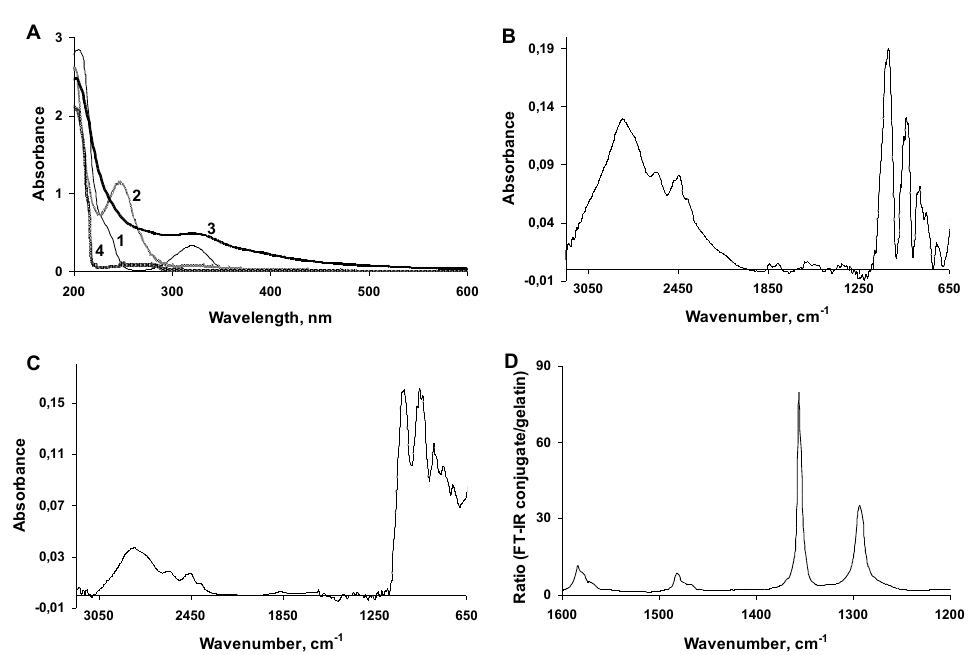
Figure 2. Analysis of the 2,5-DHBA–gelatin conjugate using UV-Vis ( A ) and FT-IR ( B – D ) spectroscopy. ( A ) Absorption spectra of 2,5-DHBA (1), laccase-oxidized 2,5-DHBA (2), 2,5-DHBA–gelatin conjugate (3), and gelatin (4); ( B , C ) FT-IR spectra of gelatin and the 2,5-DHBA–gelatin conjugate, respectively; ( D ) The ratio of FT-IR spectra conjugate/gelatin is given.